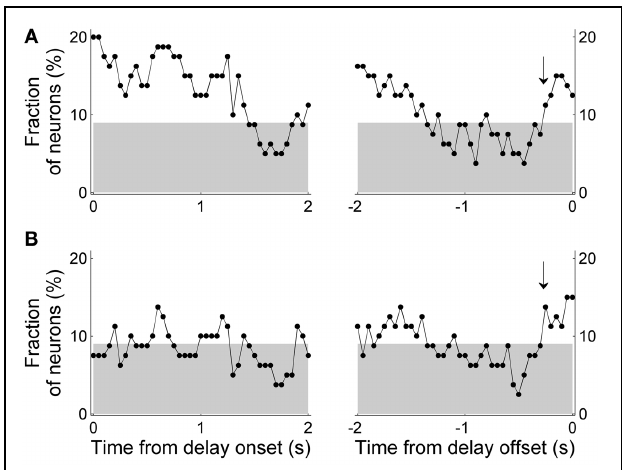
FIGURE 8 | Results of regression analysis with a relaxed criterion. Either the previous (A) or upcoming (B) goal choice (instead of both) was included in the regression model (Equations 2 and 3, respectively). Same format as in Figure 7 .